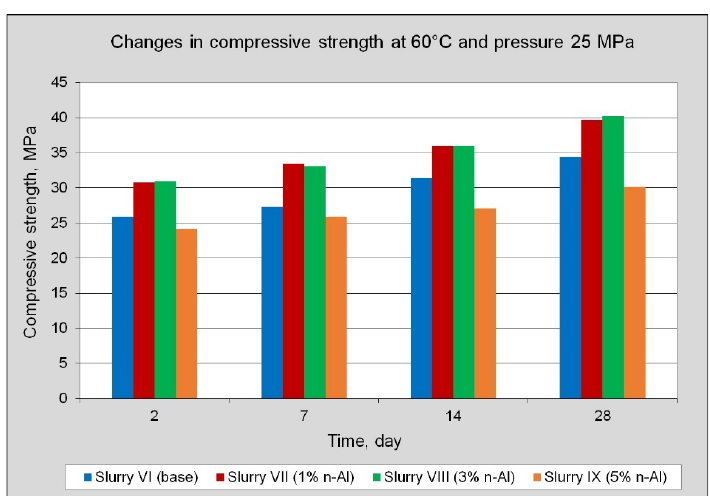
Figure 7. Changes in the compressive strength of samples VI, VII, VIII, IX after 2, 7, 14, and 28 days of hydration.